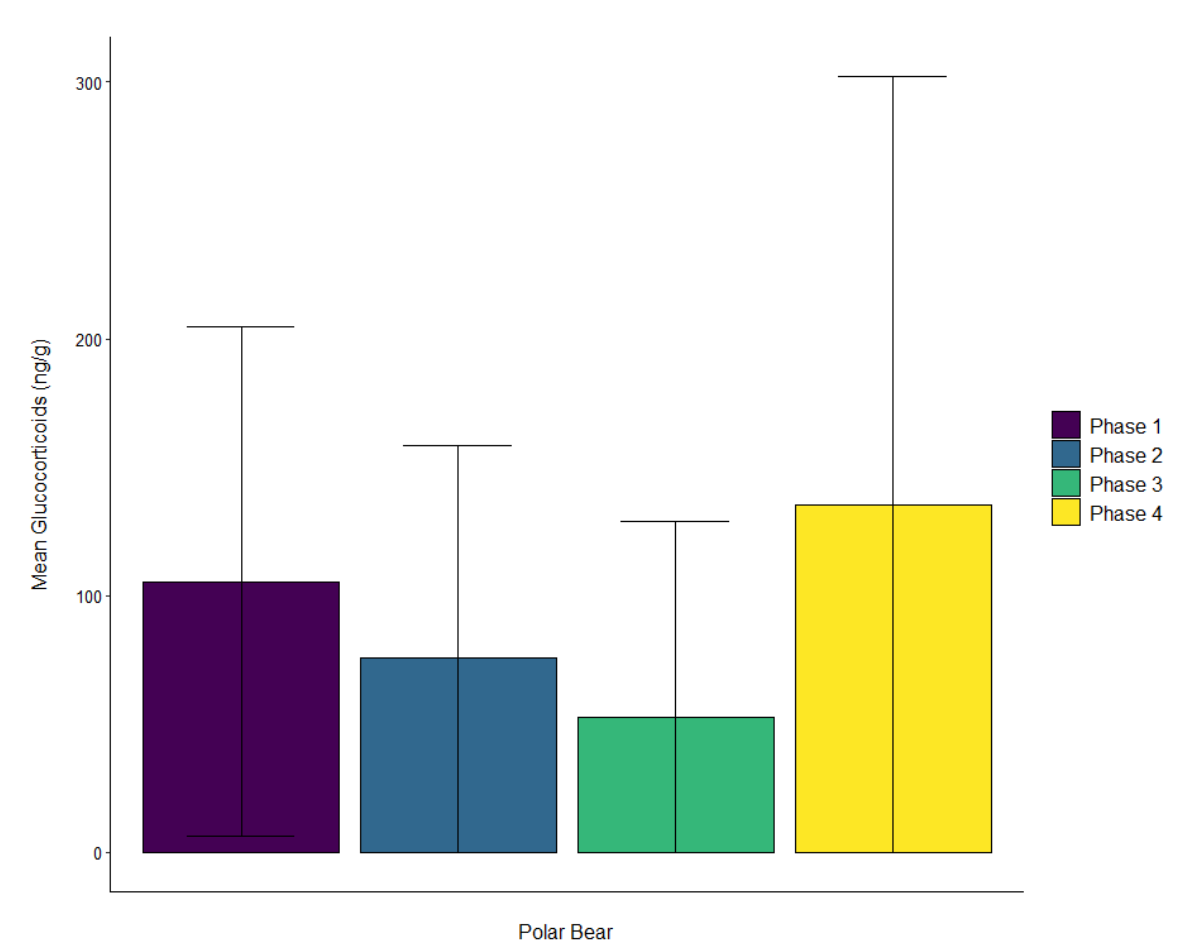
Figure 10. Means and standard deviations for fecal glucocorticoids by phase for the polar bear.